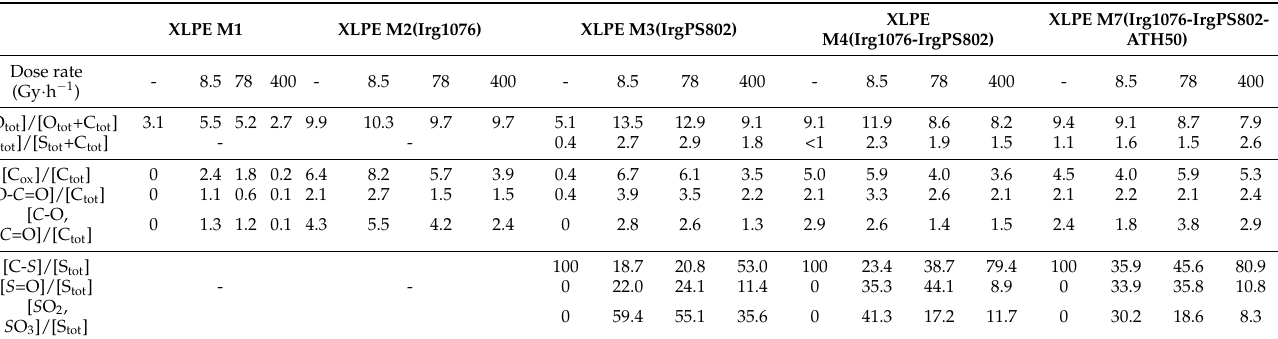
Table 2. Relative atomic ratio (at.%) obtained from curve-fitted XPS core-level spectra ( C -1s, O -1s and S -2p) for the five XLPE materials, non-irradiated and irradiated at 67 kGy. Irradiations realised at three different dose rates, i.e., 8.5, 78 and 400 Gy · h − 1 , with γ -rays under oxidative atmosphere. C ox refers to all oxidised carbon bonds, O- C =O, C -O and C =O. XLPE M2(Irg1076) XLPE M3(IrgPS802)